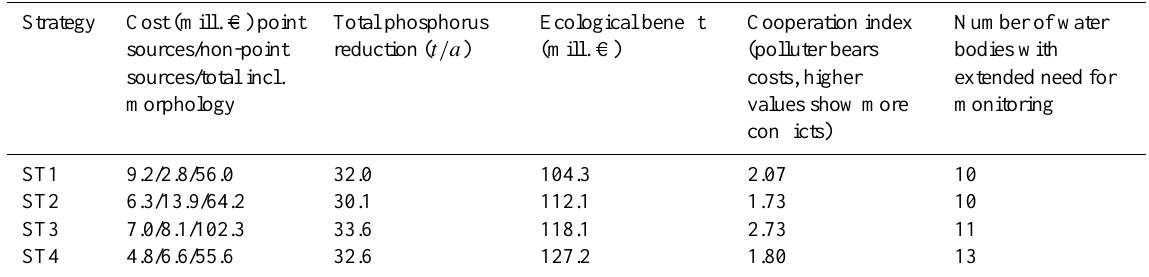
Table 2. Four catchment management strategies and respective decision criteria (from Dietrich and Funke, 2009; Dietrich and Schumann,